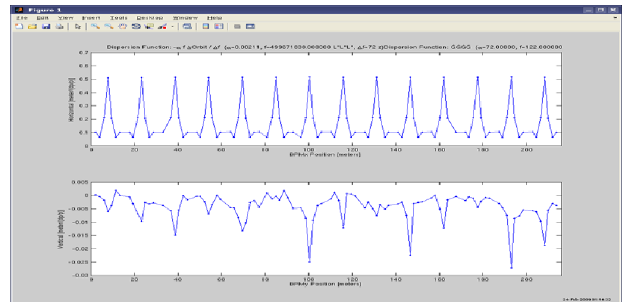
FIG. 5. Result of a typical dispersion measurement. Effects of BPM coupling can clearly be seen as the peaks of the horizontal dispersion (top) appear in the vertical dispersion plot